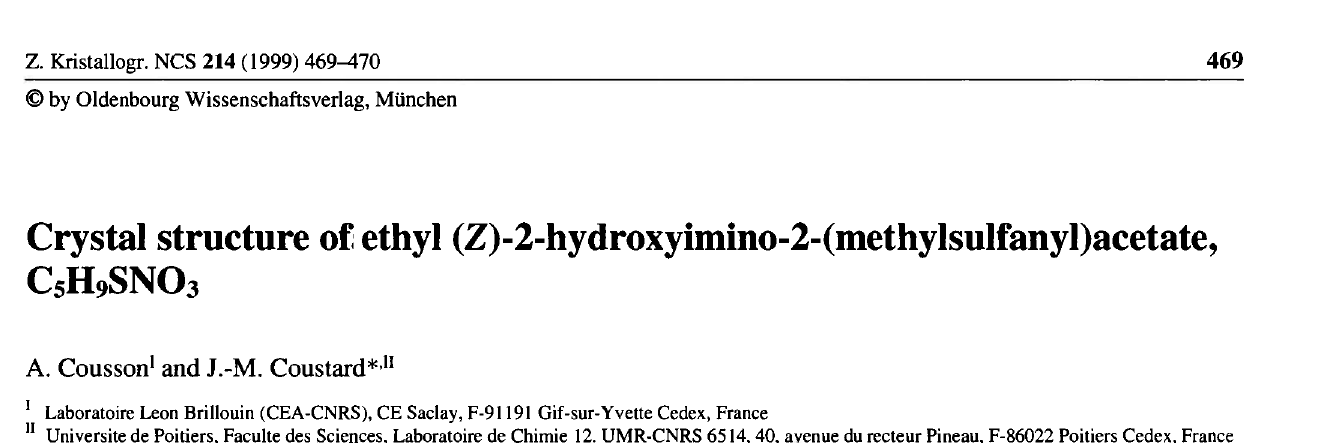
Table 1. Data collection and handling.